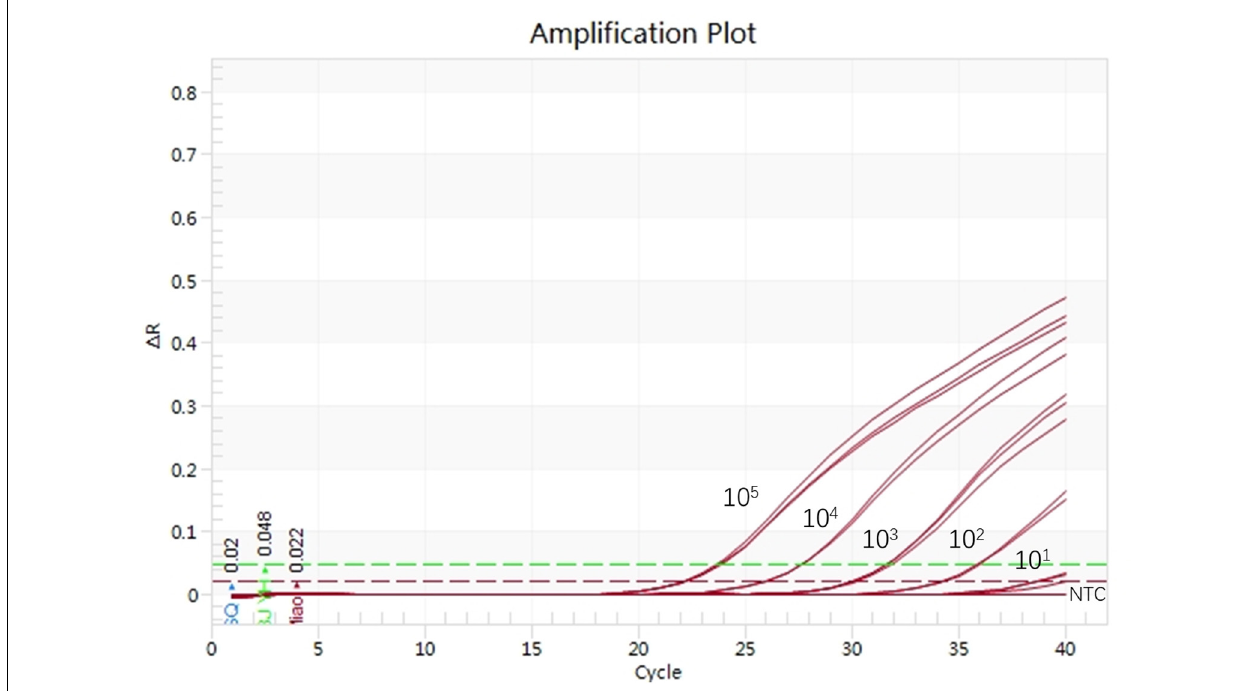
FIGURE 2 | Evaluation of the sensitivity of ASFV TaqMan real-time PCR.